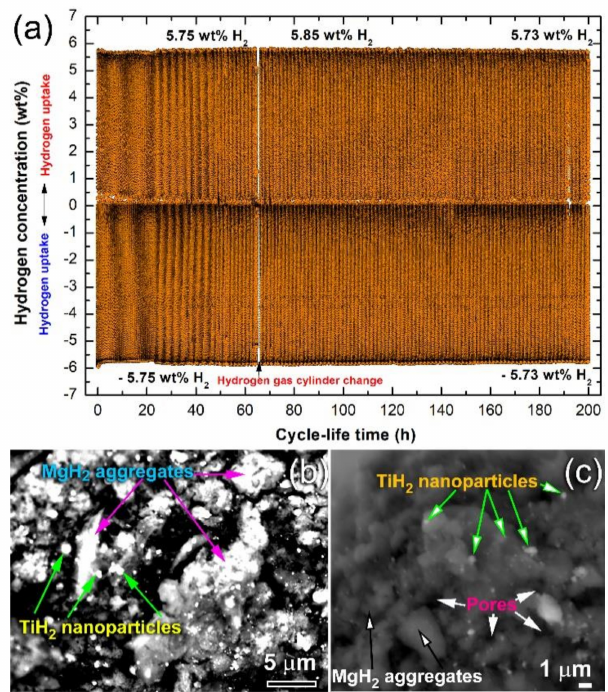
Figure 18. ( a ) Cycle-life-time curves of the 150 passes -CR sample, which was RBM for 150 h. The FE-backscattered electrons (BSE) micrographs of the samples taken after 199.5 h hydrogenation and 200 h dehydrogenation time are presented in ( b ), and ( c ), respectively. The H 2 -uptake and release were ◦ conducted at 275 C / 10 bar H 2 , and 275 ◦ C / 400 mbar H 2 ,